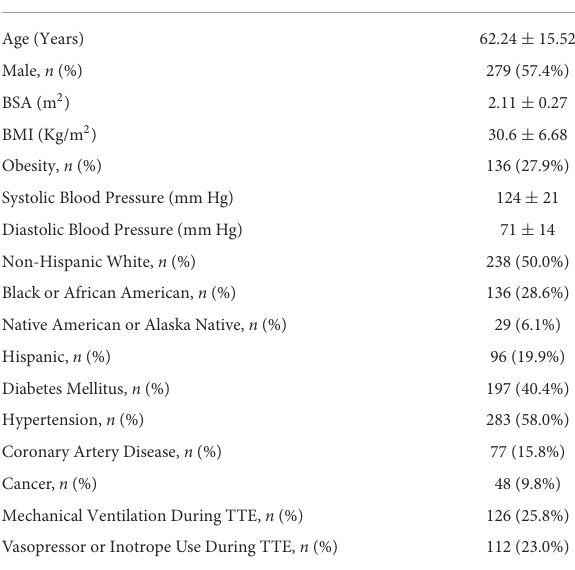
TABLE 1 Baseline patient